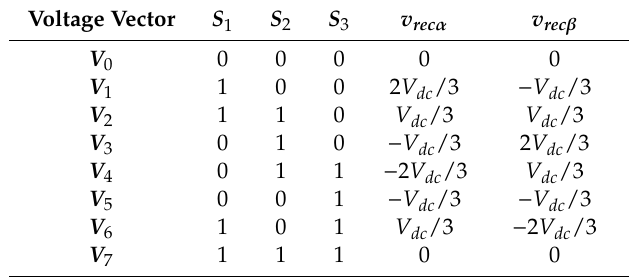
Table 1. Voltage vector, switching states, and rectifier input voltage. Voltage